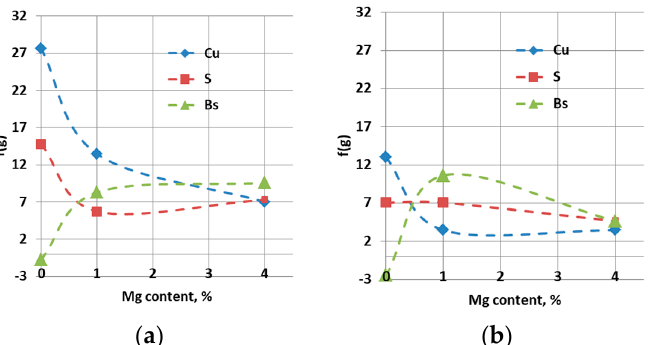
Figure 11. Magnesium content effect on the main β -fiber texture components’ abundance: ( a ) 10 s − 1 , temperatures 300 °C; ( b ) 10 s − 1 , temperatures 450 °C.